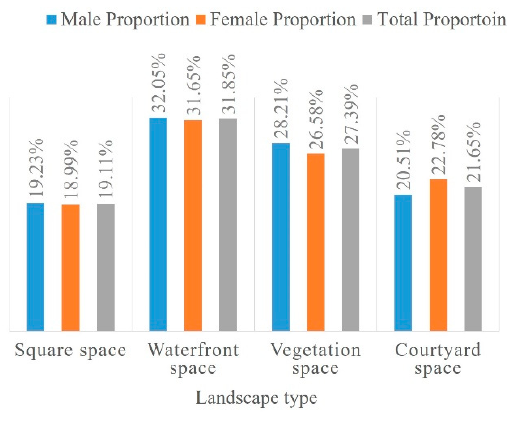
Figure 2. Landscape type preference.